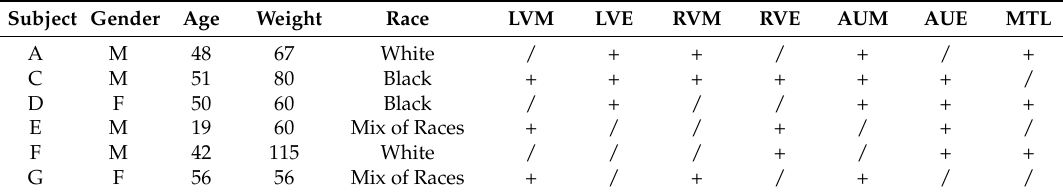
Table 2. Clinical information about the heart donors and the hH-EV pool construction.